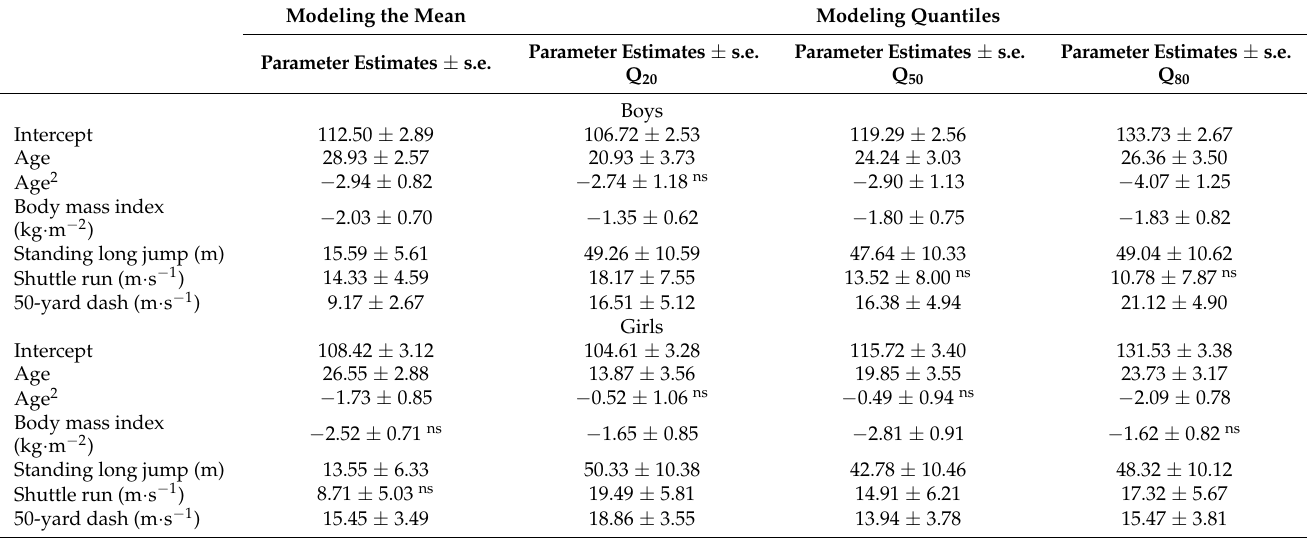
Table 2. Parameter estimates ( ± standard errors) for all subjects using mean-modeling and estimates for the three quantiles–Q 20 , Q 50 , Q 80 in both boys and